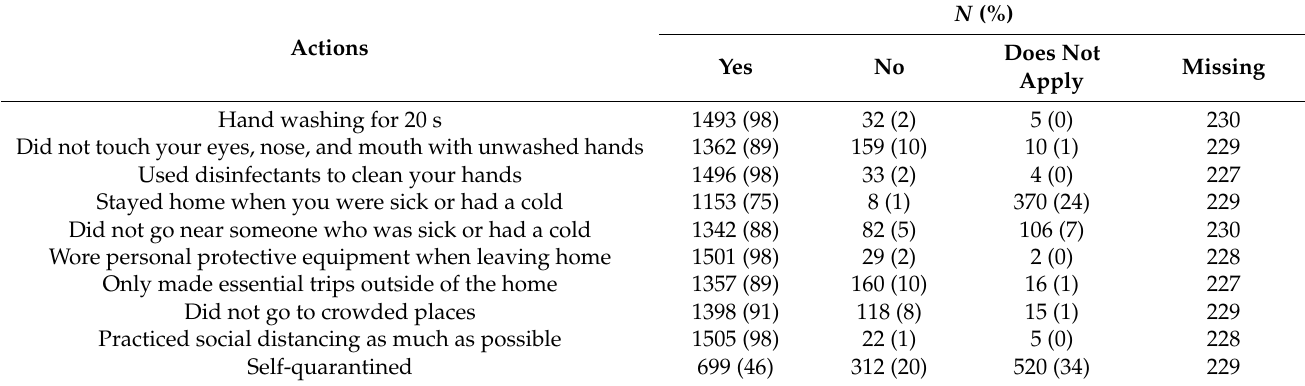
Table 7. COVID-19 preventative behaviours.